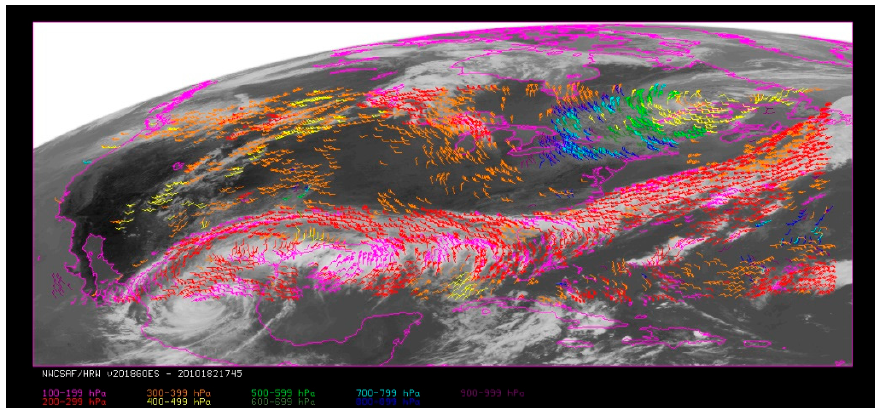
Figure 15. NWC/GEO-HRW v2018.1 AMV output example in the Continental United States region considering the default conditions for processing (1 July 2010, 17:45 UTC, GOES-13 satellite). Color coding based on the AMV pressure. Table 6. Validation for NWC/GEO-HRW v2018.1 AMVs against radiosonde winds, considering all AMVs together and in three separate layers: high levels: 100–400 hPa; medium levels: 400–700 hPa; low levels: 700–1000 hPa (Jul 2010–Jun 2011, 05:45/11:45/17:45/23:45 UTC, GOES-13 satellite, continental United States region).